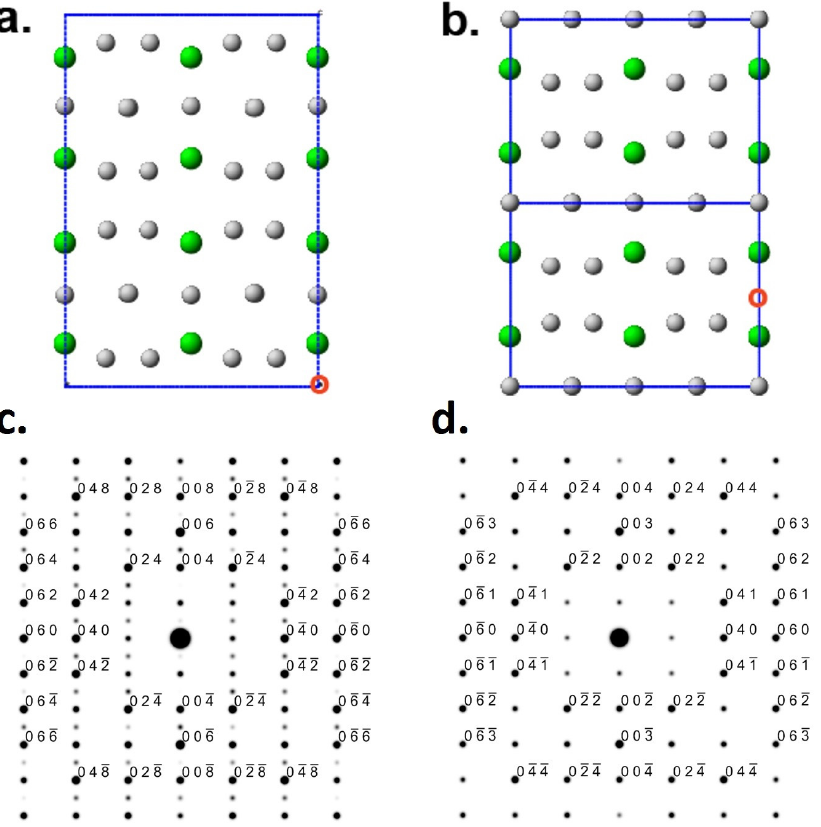
Figure 8. Projection of the Zr 2 Ni 7 structure in the [100] direction for a structural model of Eshelman [24] and Parthe [27] ( a ), a projection of the layers from ( a ) with an outlined pseudo-hexagonal unit cell ( b ) and simulated SAED patterns with the electron beam’s direction normal to the layers’ planes (ZA = [0.24 0 0.9]) for very thin (1 nm) ( c ) and thicker (10 nm) ( d ) Zr 2 Ni 7